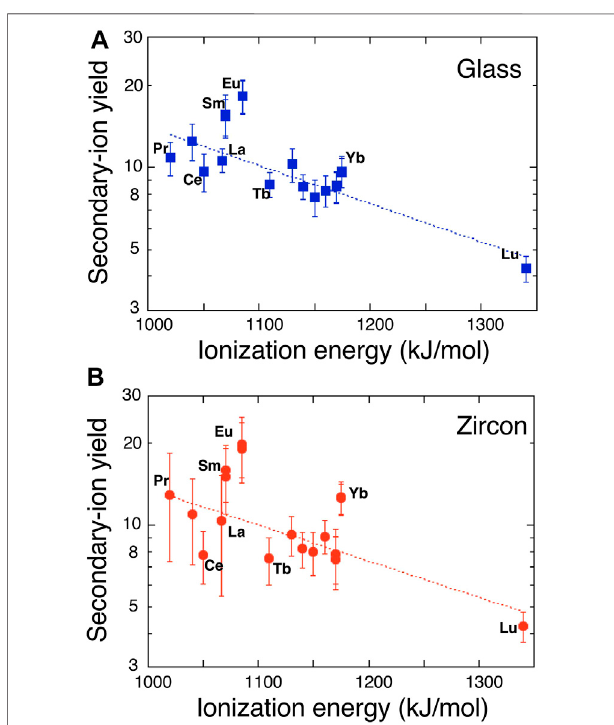
FIGURE 1 | A correlation diagram between ionization energy of the secondvalenceofrareearthelementsandlogarithmofsecondary ionyieldsin (A) glass standard SRM610and (B) zircon standard 91500. Errorassigned to the symbol is 2 σ . Dotted lines are the best fi ts of Eq. 1 .